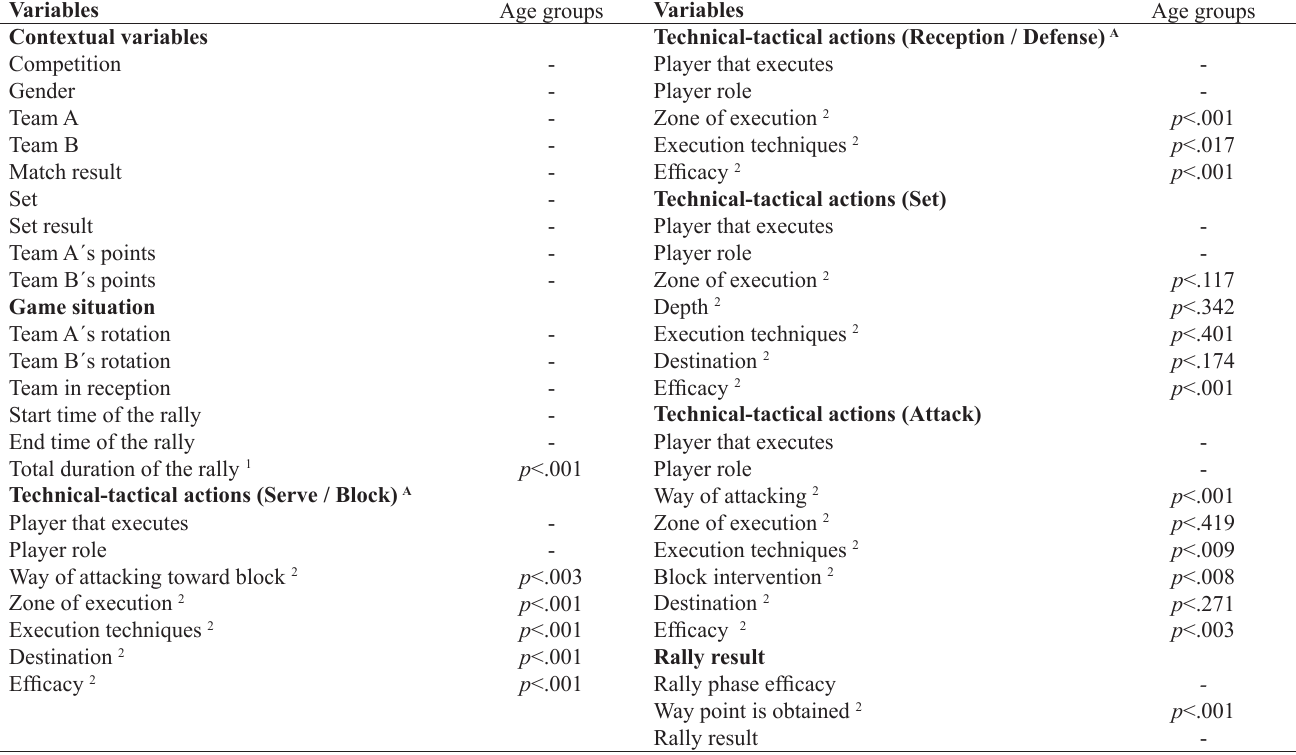
7. Differences found using the observation instrument between competitions of different age groups (seventh